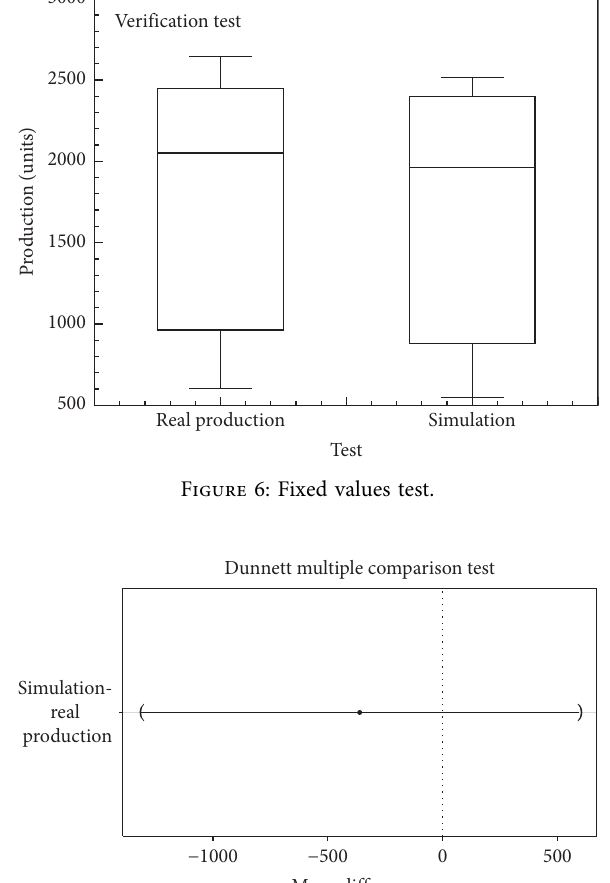
Figure 7: Operational